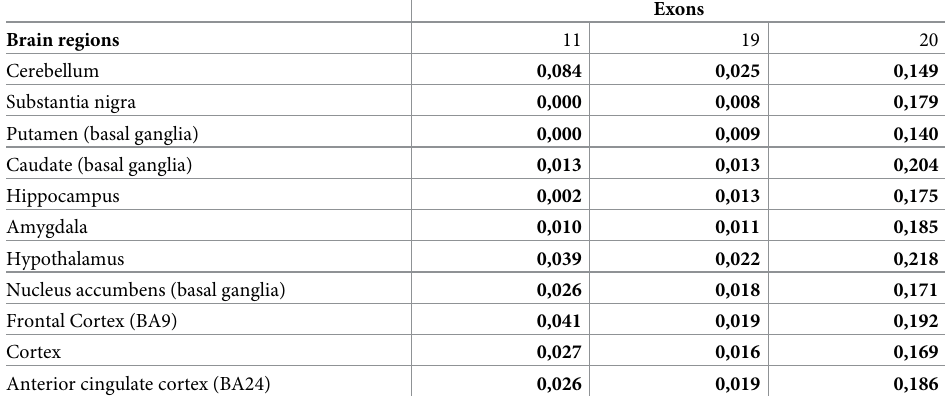
Table 1. Usage of exons 11, 19 and 20 in CASK transcript variants sorted by brain regions according to the Geno- type-Tissue Expression (GTEx) database.